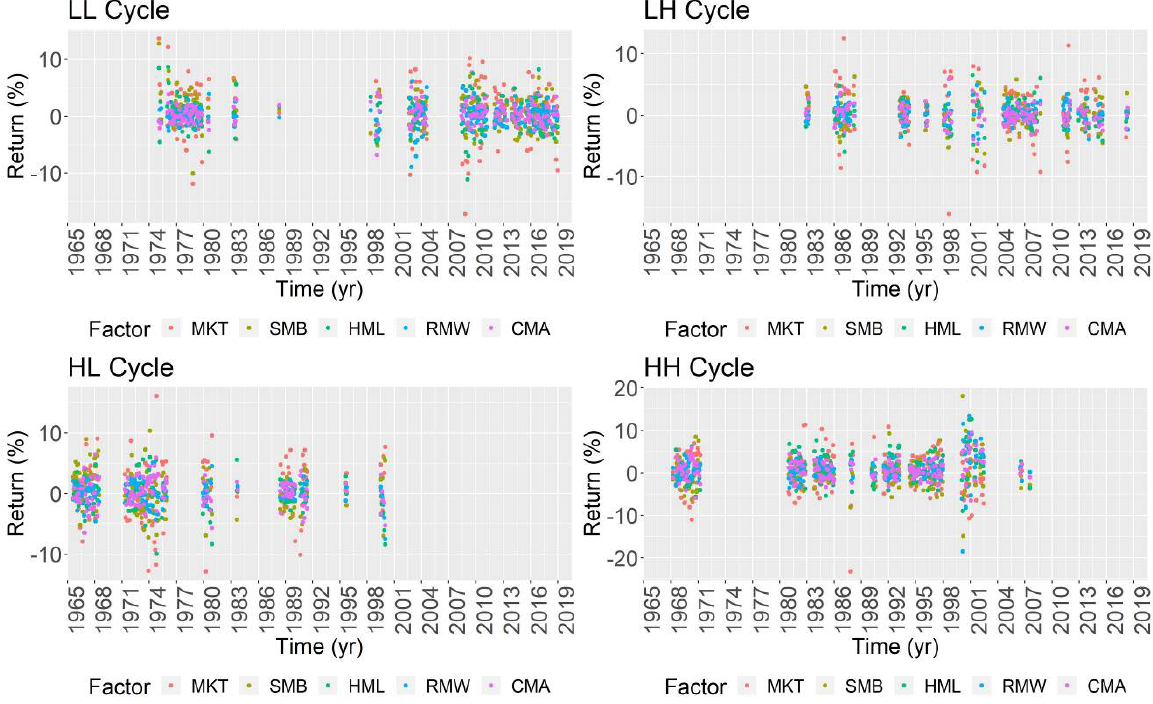
Figure A1. Time-series distribution of five-factor returns in market cycles (1965–2018). LL, LH, HL, and HH denote the low-interest rate and low-sentiment, low-interest rate and high-sentiment, high-interest rate and low-sentiment, and high-interest rate and high-sentiment cycle, respectively.